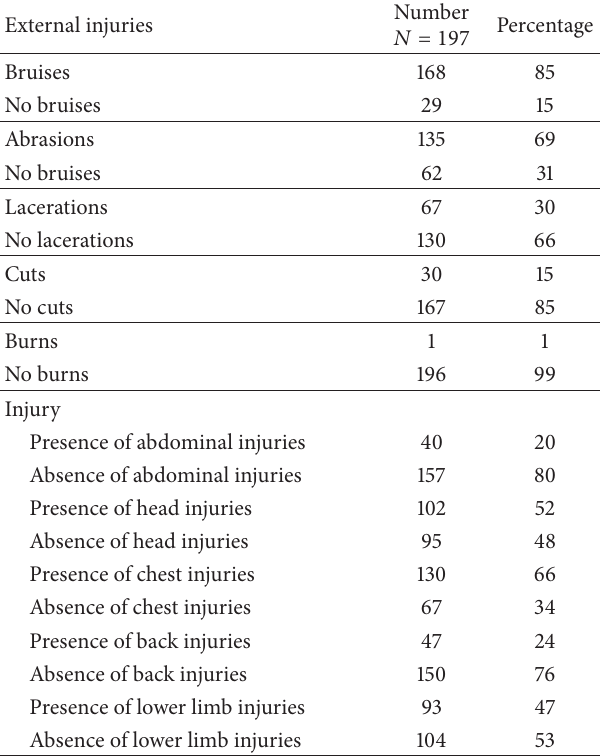
Table 1: Distribution of characteristics between EFAST and stan- dard of care.